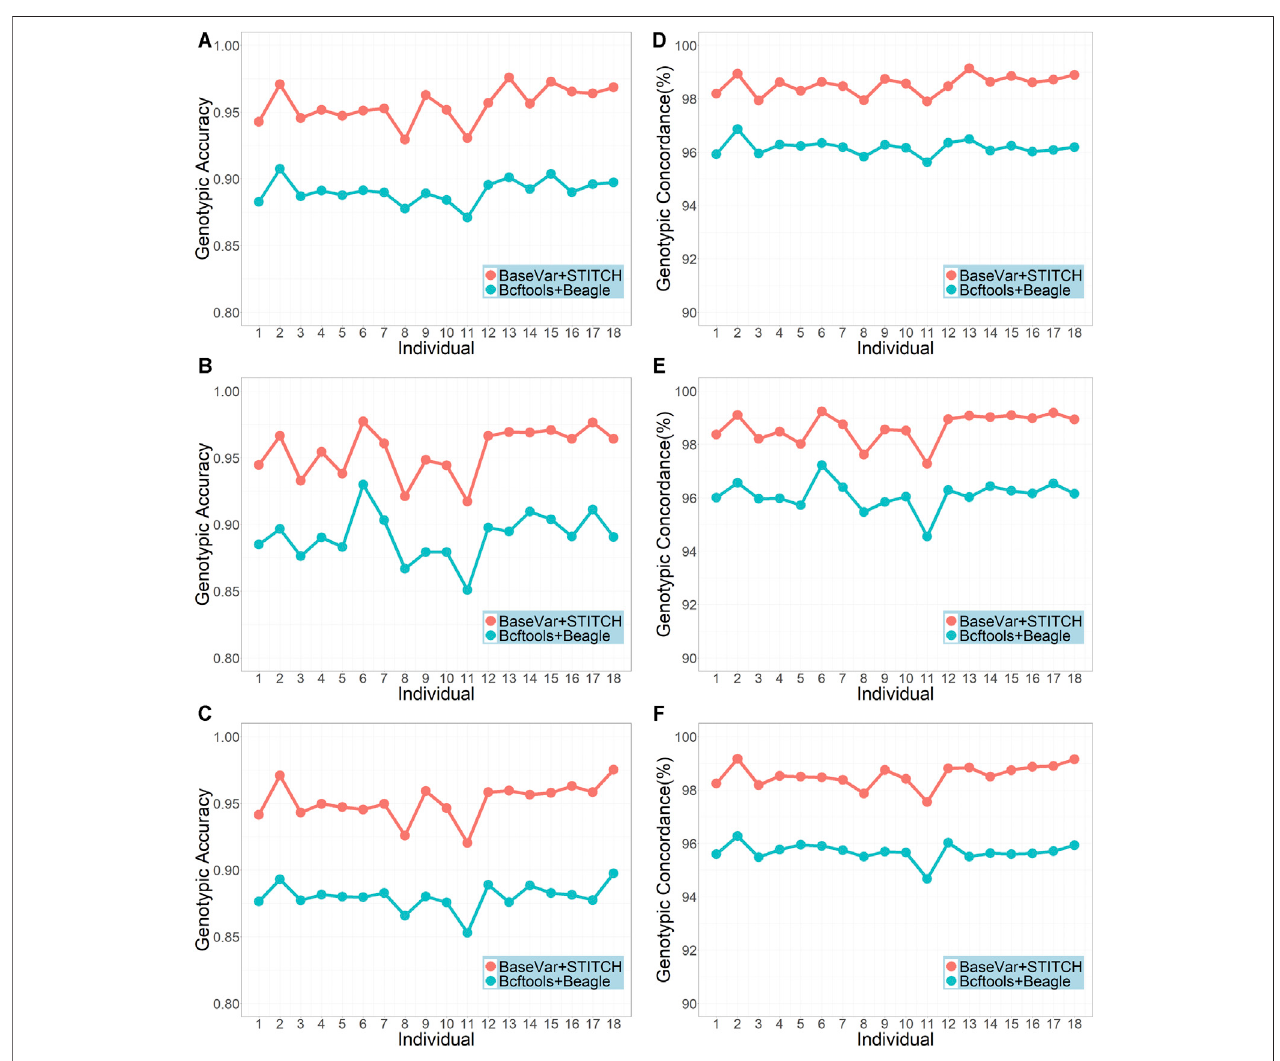
FIGURE 1| Genotypic accuracy and genotypic concordance using the twoimputation pipelines (sample size (cid:1) 617 and average sequencingdepth (cid:1) 3.5x). (A – C) represent genotype accuracy for chromosomes 1, 19, and 30, respectively; (D – F) represent genotype concordance for chromosomes 1, 19 and 30, respectively.